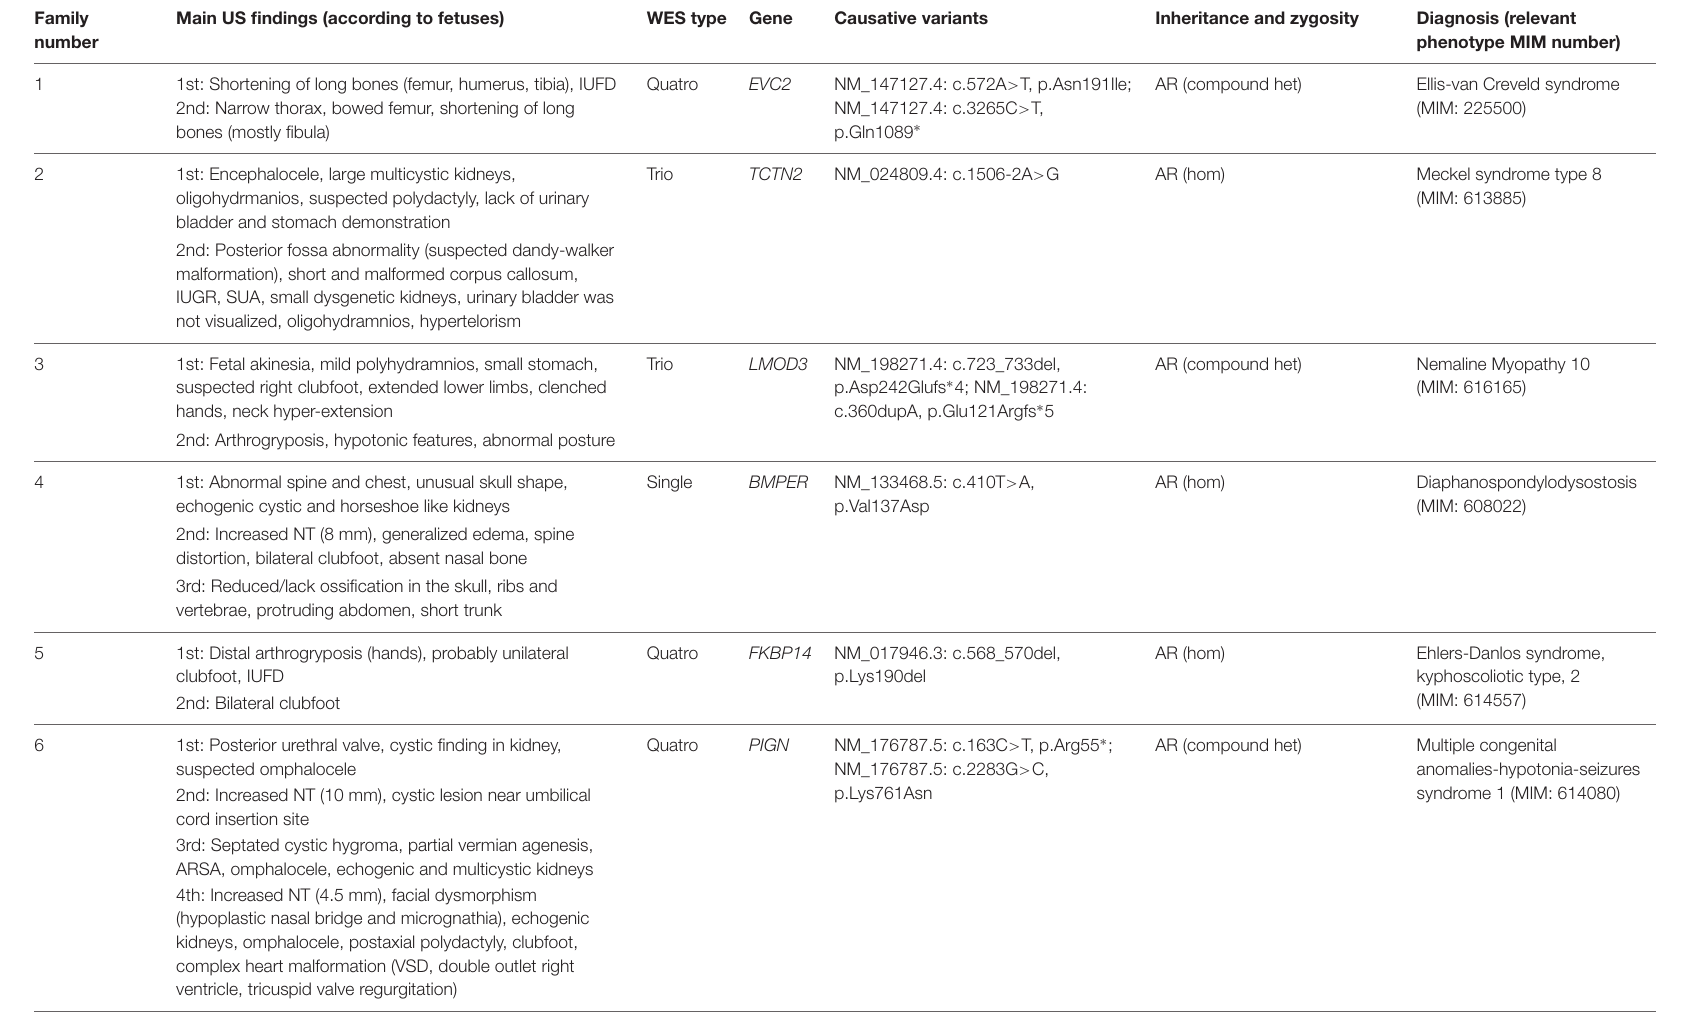
TABLE 2 | Resolved 13 families- summary of main US findings, WES results and final molecular diagnosis. Family